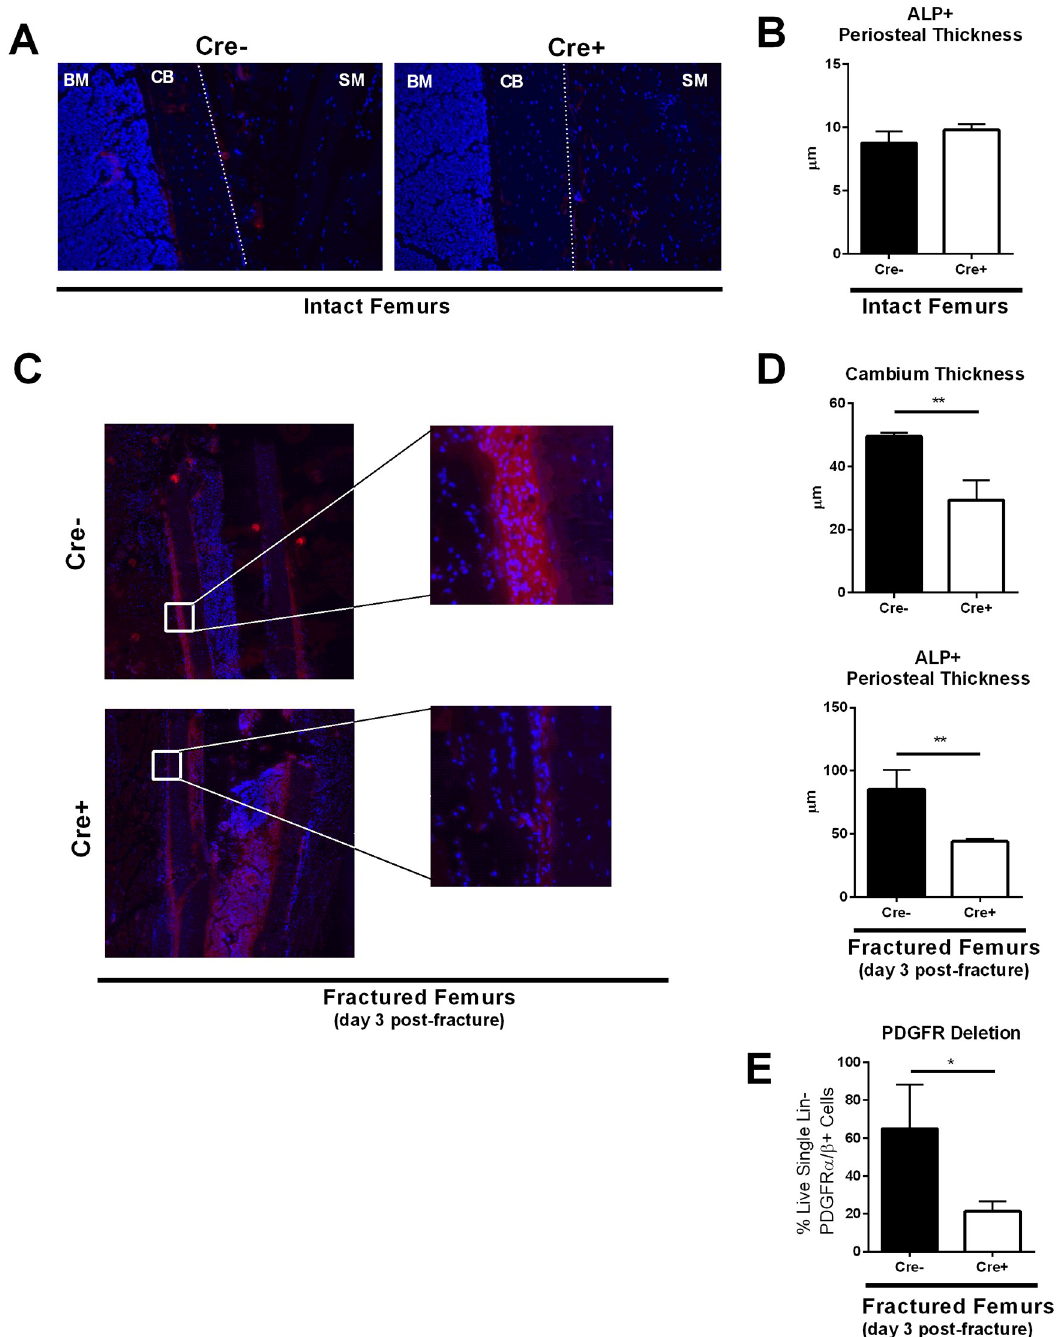
Fig 4. α SMA-Cre-mediated removal of PDGFR β in periosteal progenitors after bone injury dramatically reduces the periosteal response to fracture seen in gCbl YF mice. (A) Representative images of the periosteal thickness and ALP activity in intact bones. 10x magnification. Blue = DAPI, red = ALP activity stain. BM = bone marrow, CB = cortical bone, dotted lined = periosteum, SM = skeletal muscle. N = 3–4 biological replicates per group. (B) Quantification of ALP activity stain thickness ( μ m) in intact bones. Tamoxifen (75 μ g/g body weight) for conditional deletion of PDGFR β was administered at days 0 and 1 prior to sacrifice. N = 3–4 biological replicates per group. (C) Fractured femurs from Cre- and Cre+ mice at 10x magnification (Table 1). Representative images of the periosteal thickness and ALP activity 1500 μ m from the fracture site at day 3 post-fracture. Blue = DAPI, red = ALP activity stain. CB = cortical bone, SM = skeletal muscle. Tamoxifen (7.5 μ L/gram) for conditional deletion of PDGFR β was administered at days 0 and 1 post-fracture. N = 3–4 biological replicates per group. (D) Quantification of cambium layer thickness and ALP